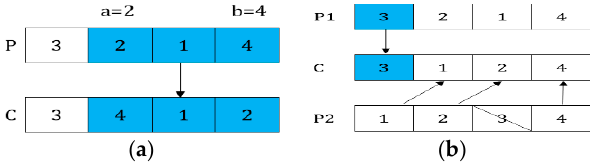
Figure 3. Schema of the leadership level learning strategies. ( a ) Fliplr mutation. ( b ) LOX crossover. The pseudocode for the core part of LOX cross-mutation is outlined in Algorithm 3. Algorithm 3. LOX cross-mutation.